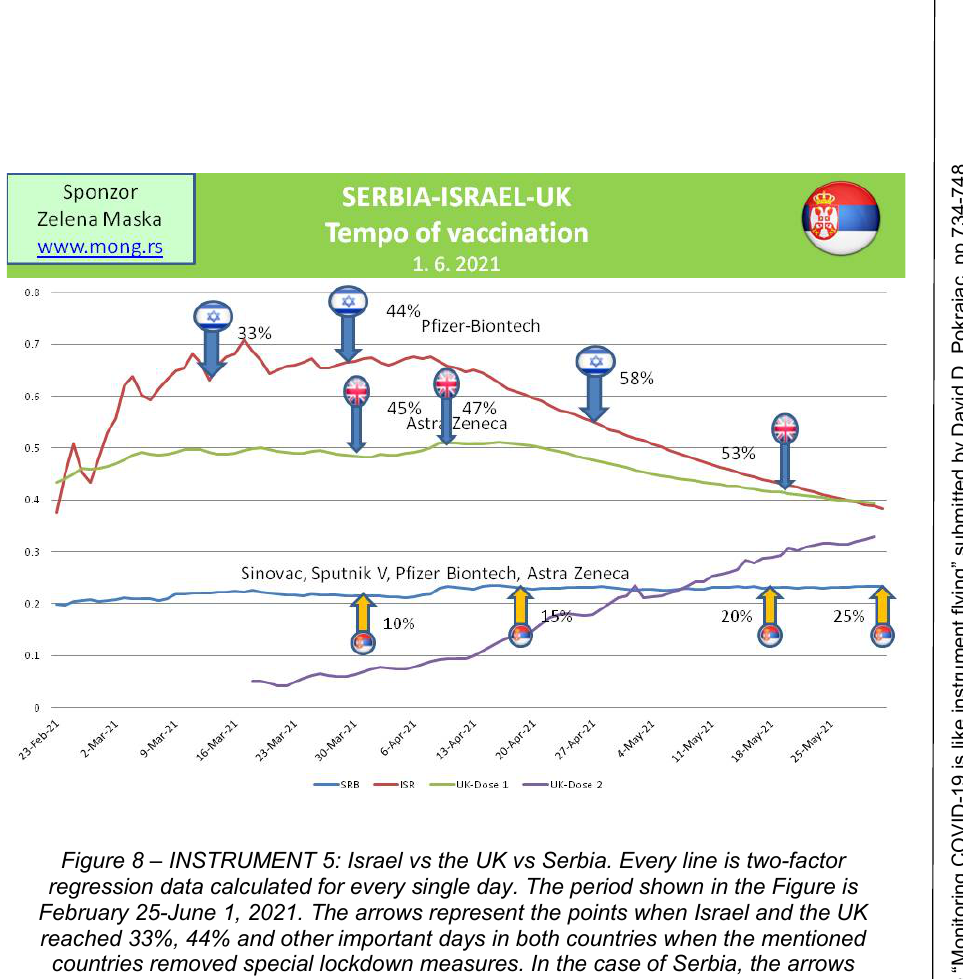
Figure 8 – INSTRUMENT 5: Israel vs the UK vs Serbia. Every line is two-factor regression data calculated for every single day. The period shown in the Figure is February 25-June 1, 2021. The arrows represent the points when Israel and the UK reached 33%, 44% and other important days in both countries when the mentioned countries removed special lockdown measures. In the case of Serbia, the arrows represent the dates when the country reached 10%, 15%, 20%, and 25% of the immunized population. (Note: Astra Zeneca takes 12 weeks between the first and second dose, Sinovac takes 4 weeks after the second dose. All other vaccines need 3 weeks after the second dose to reach full